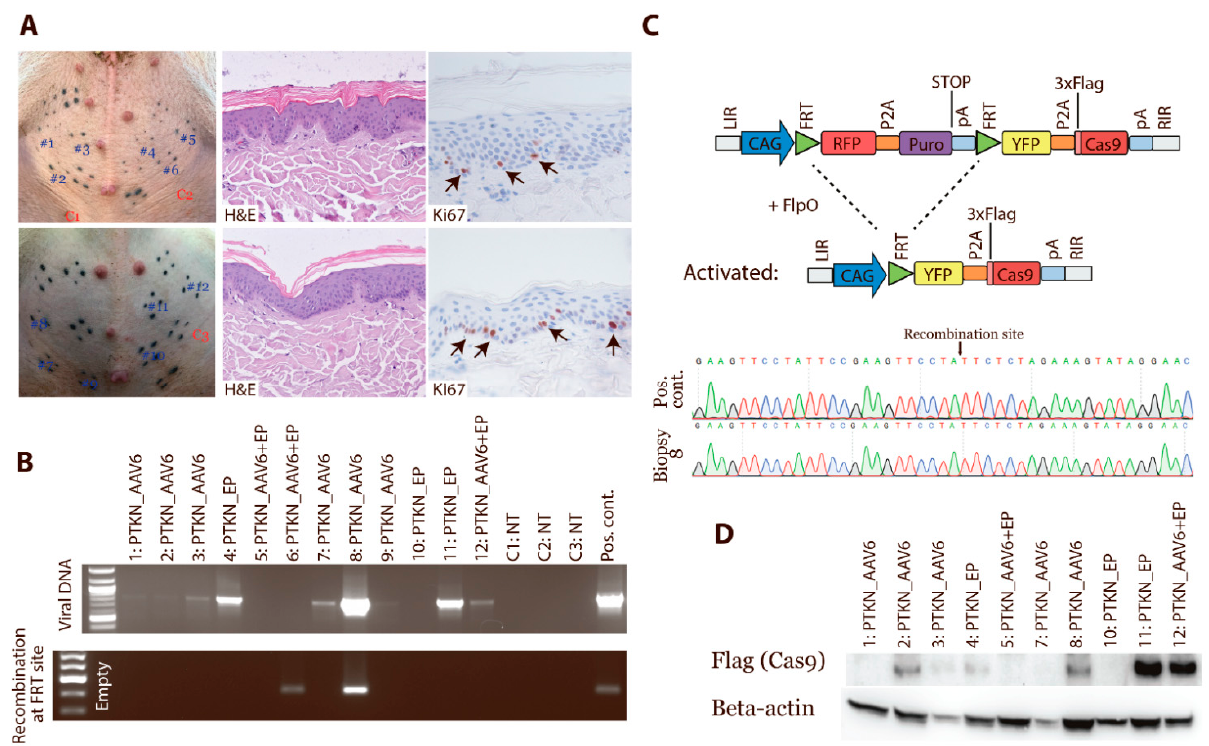
Figure 4. In vivo activation of Cas9 expression. Cas9 minipigs were transduced in multiple areas in the abdominal skin, and biopsies were taken after 1 month. ( A ) Tissue sections from transduced areas and control skin were stained for H&E and Ki67 ( n > 3). ( B ) Biopsies were analysed for the presence of viral DNA and for recombination at the FRT sites and hereby activation of Cas9 expression. The PTKN construct was used as either plasmid or in AAV6 particles. Some areas underwent electroporation (EP) to enhance the delivery. NT: nontreated. ( C ) Two samples underwent Sanger sequencing to confirm recombination of the transposon at the FRT sites. ( D ) Proteins isolated from the biopsies were analysed by Western blotting for Cas9-Flag expression. Beta-actin was used as loading control. Western Blot Images can be found in Figure S7.